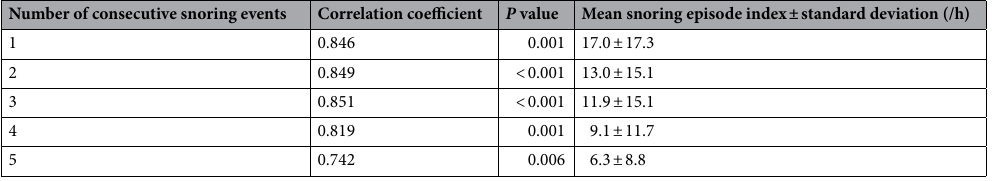
Table 2. Validation of the optimal number of consecutive snoring events in a snoring episode.